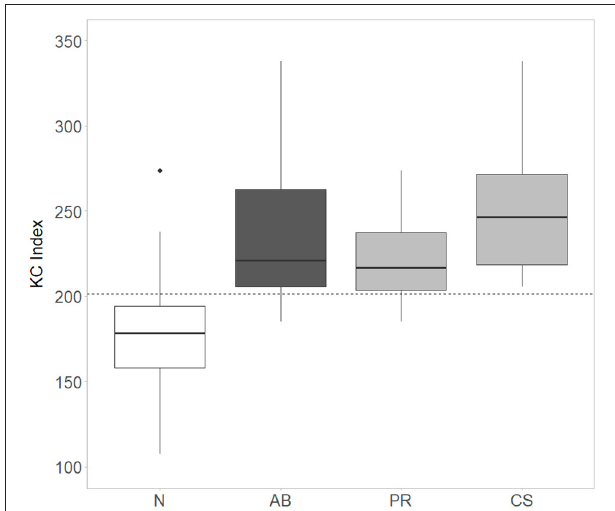
FIGURE 2 | Distribution of the KC_Index for normal (N), abnormal (Ab = CS + PR), poor repertoire (PR), and cramped synchronized (CS) subjects. The identified KC_Index cutoff is indicated by the dashed line. Comparison between N, PR, and CS groups: p < 0.001. N vs. PR, p < 0.001; N vs. CS, p < 0.001; PR vs. CS, p = 0.095, ANOVA with Tukey’s HSD post-hoc test.